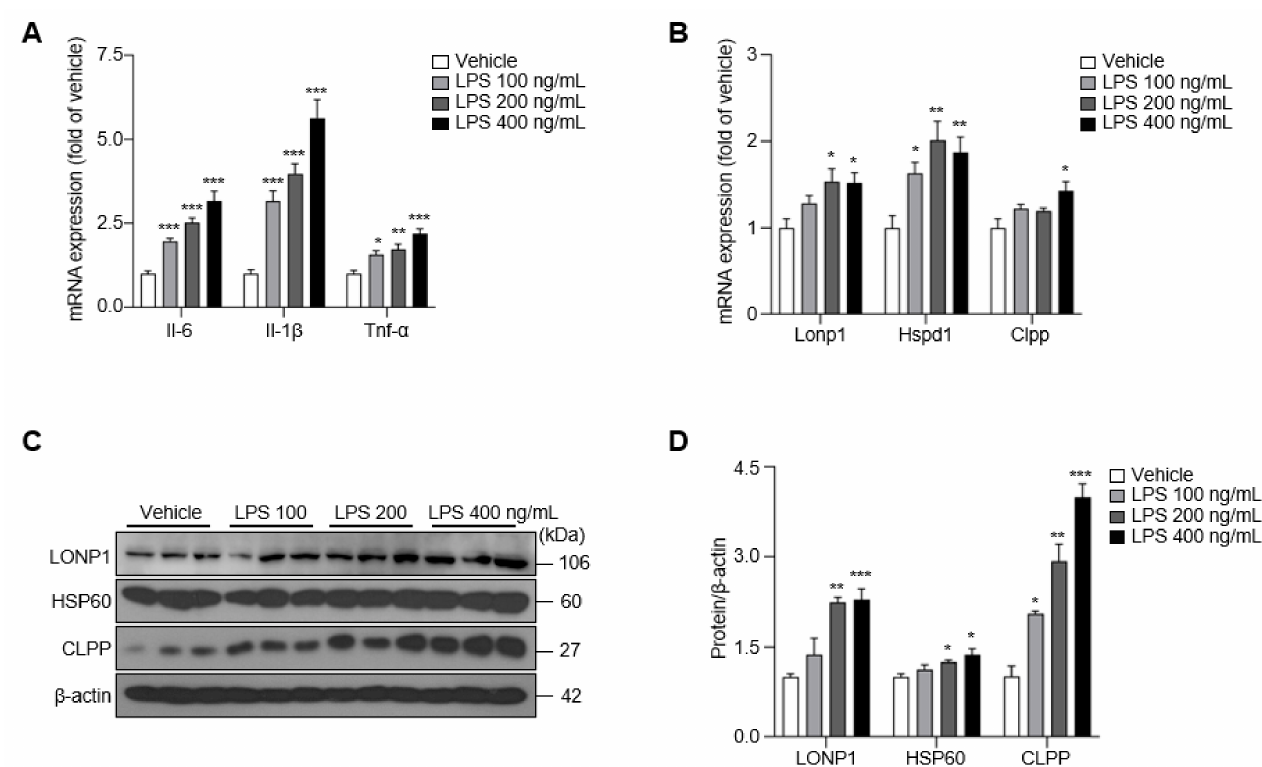
Figure 1. The expression of pro-inflammatory cytokines and UPRmt was upregulated in LPS-treated BV-2 cells for 48 h. ( A ) The expression of Il-6 , Il-1 β , and Tnf- α in LPS-treated BV-2 cells. ( B ) The expression of Lonp1 , Hspd1 , and Clpp in LPS-treated BV-2 cells. ( C ) The expression of LONP1, HSP60, and CLPP in LPS-treated BV-2 cells. ( D ) The intensity value of LONP1, HSP60, and CLPP was shown. Data are presented as mean ± SEM of three independent experiments (* p < 0.05, ** p < 0.01, *** p < 0.001 compared to